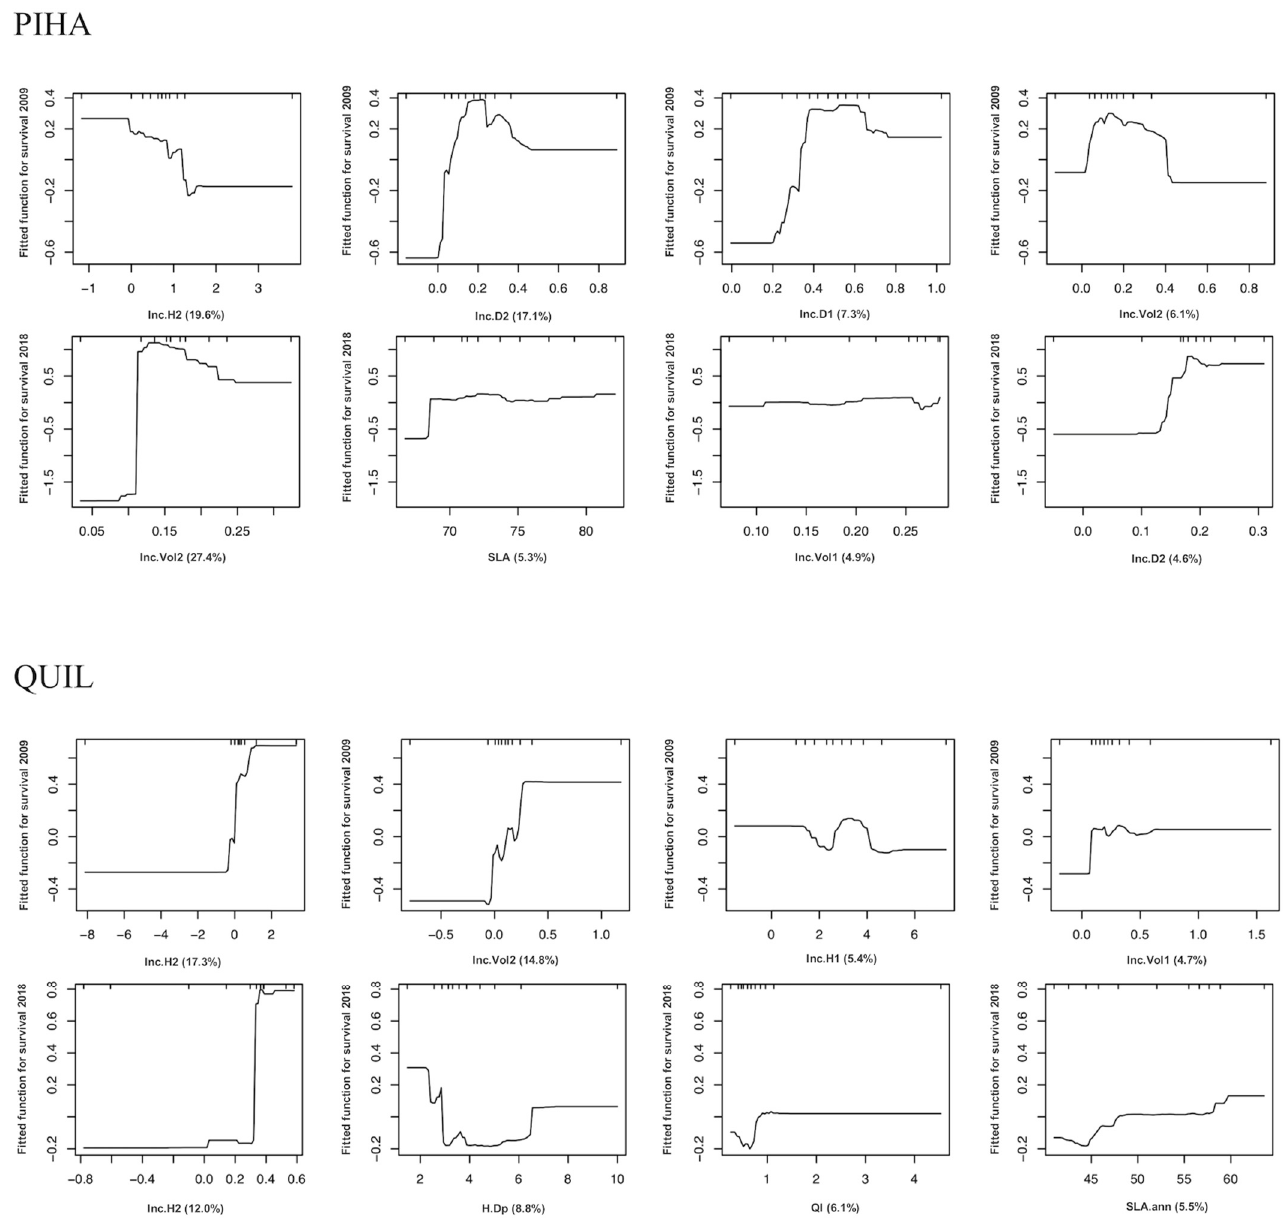
Figure 6. Partial dependence plots (PDP) of boosted regression tree (BRT) models showing the fitted functions of the 4 highest-ranked predictors (higher relative importance in the BRT models) on plantation survival performance (2009 and 2018) of Aleppo pine and Holm oak. Full sets of PDP for 2008, 2009, and 2018 in all species are presented in Supplementary Figure S2. The y -axis is centered to have zero mean over the data distribution and spans the same range (in units of logit (p) from the mean predicted response value) across all plots to make the magnitude of the effects comparable among predictors. X-axes show rug plots that visualize the distribution of the respective data space in deciles, in order to avoid overinterpreting regions with almost no data. Full names and units of the predictors ( x -axis) are provided in Table 2.